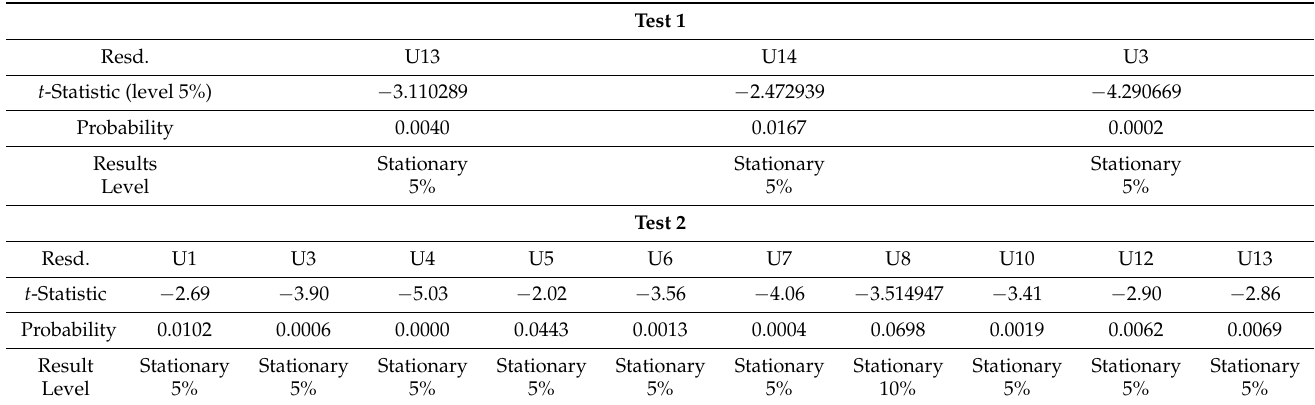
Table 3. The unit root test for residuals according to the ADF test (Tests 1 and 2). Test 1